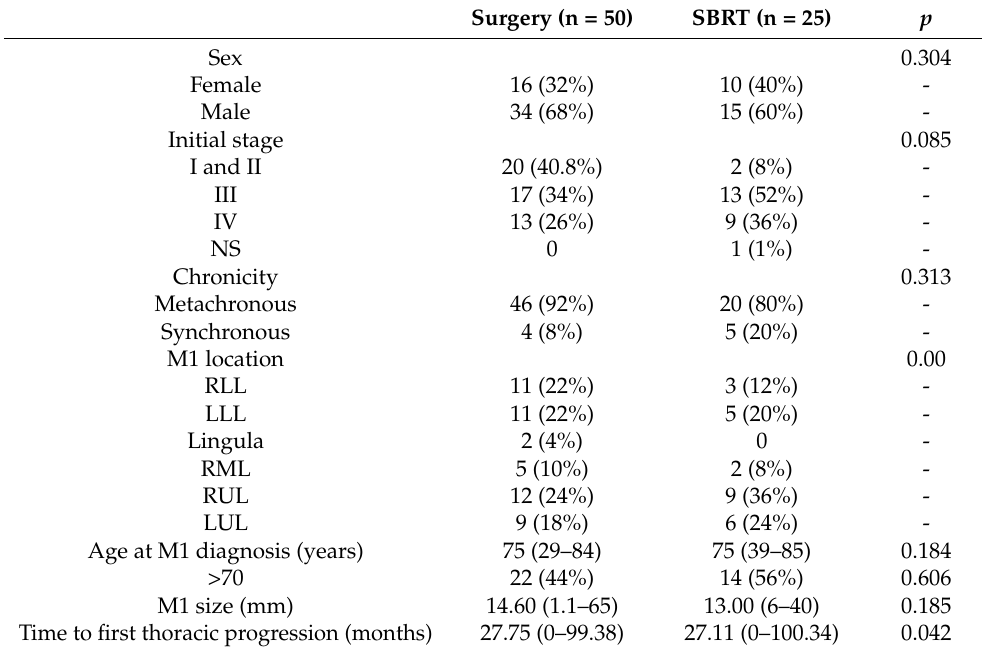
Table 2. Patient and treatment characteristics in SBRT and surgery groups (FLP